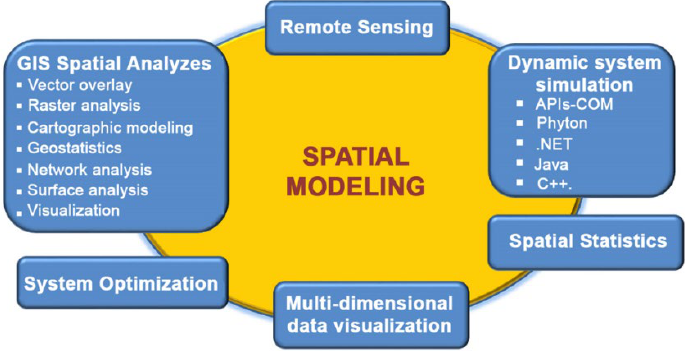
Figure 1 Spatial modelling